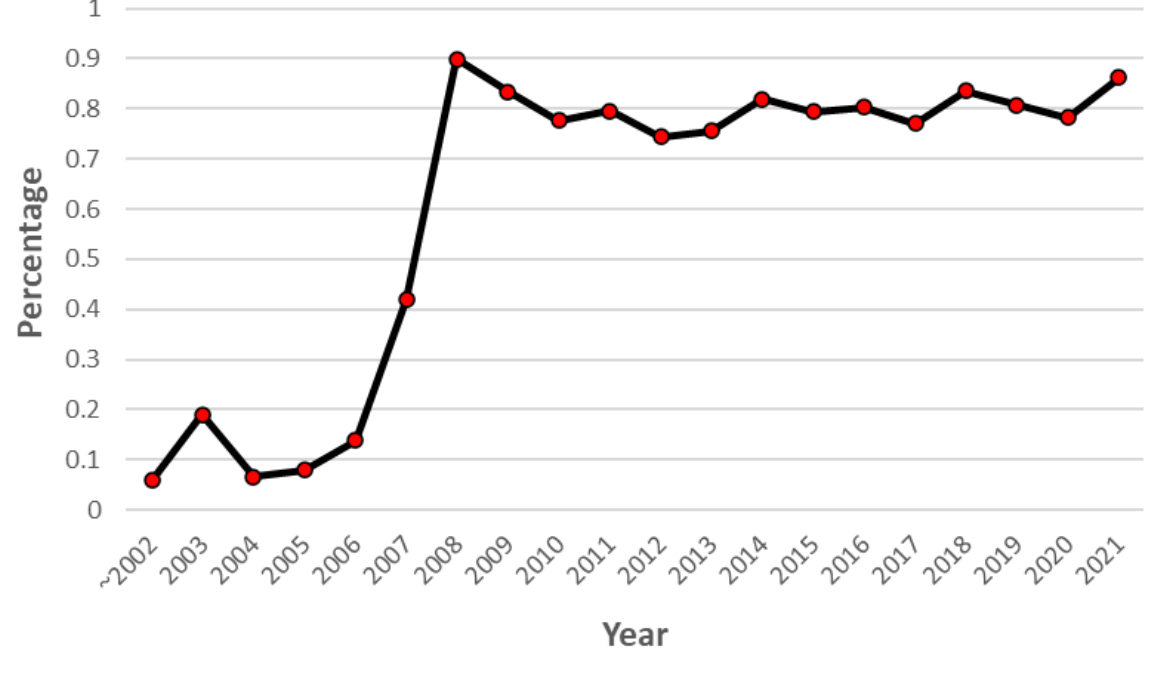
Figure 9. Changes in the percentage of CVE-ID linked to CWE-ID by year.